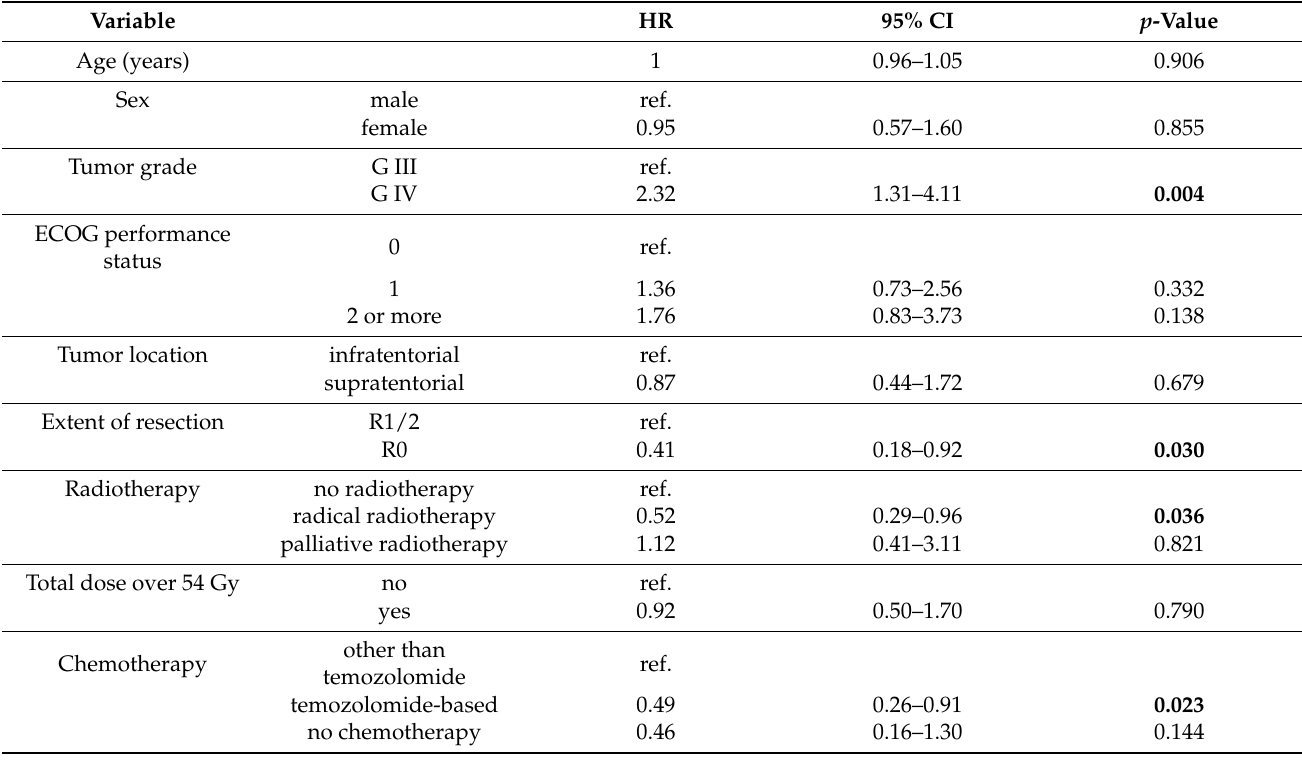
Table 2. Prognostic factors: univariate analysis of overall survival for the whole cohort.